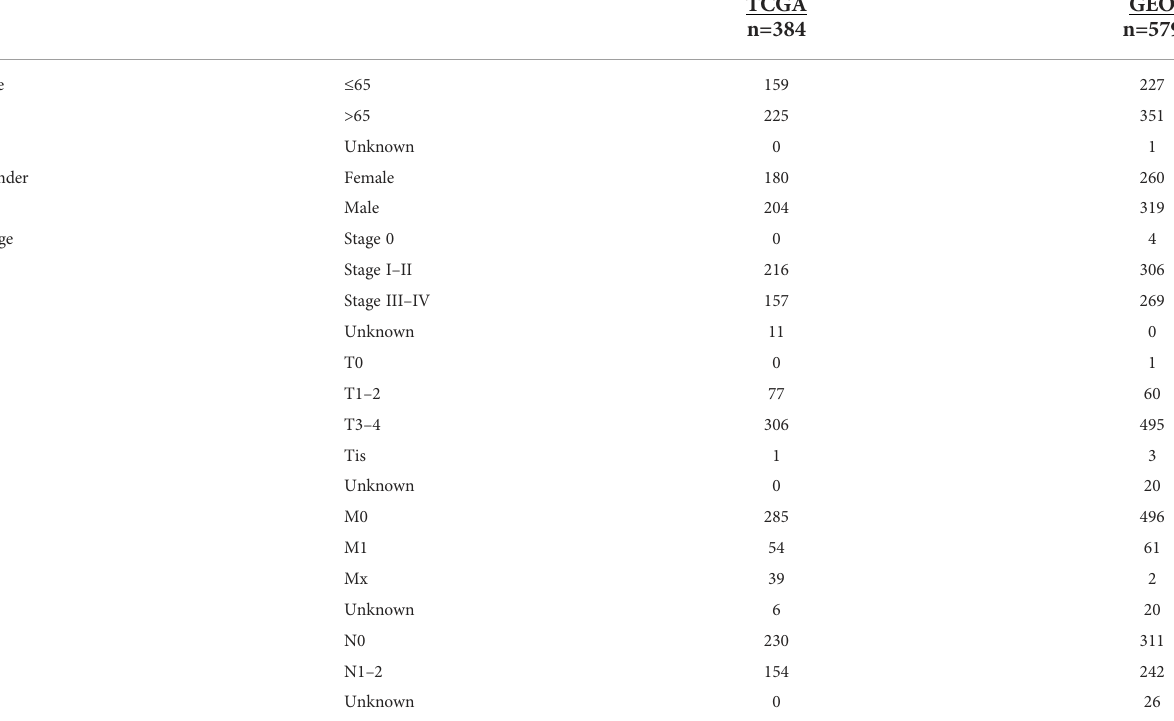
TABLE 2 Clinical information of COAD patients from TCGA and